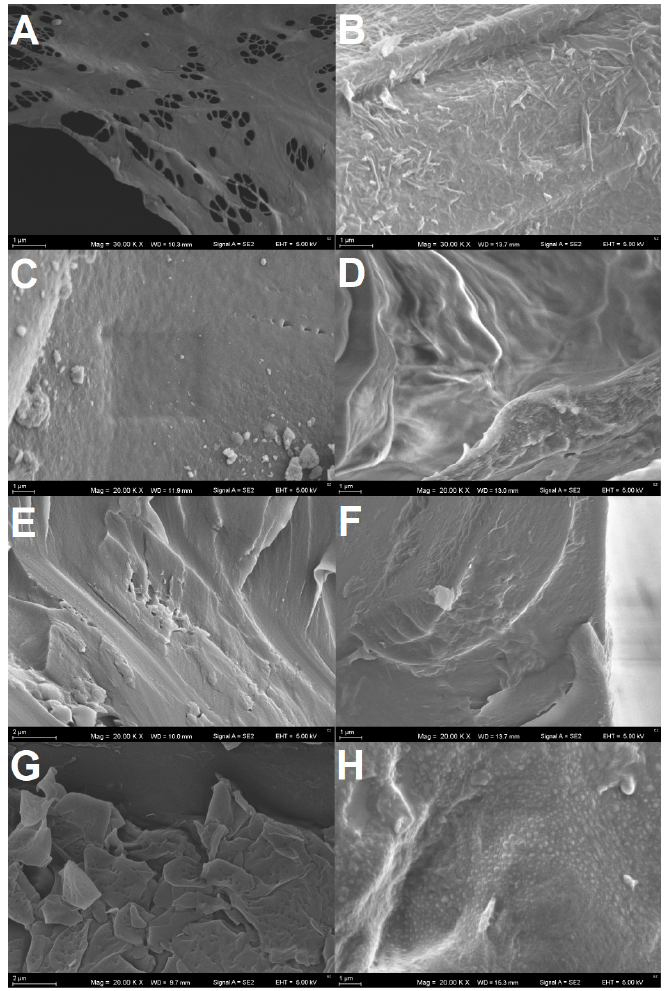
Figure 4. SEM microphotography of the plastic samples taken for the experiment ( A , C , E , G ) and plastics isolated from the insect frass after the experiment ( B , D , F , H ). ( A , B ): PS (30,000 × ); ( C , D ): PU1 (20,000 × ); ( E , F ): PU2 (20,000 × ), ( G , H ): PE (20,000 × ). Magnifications were selected to best illustrate the differences in the surface of the